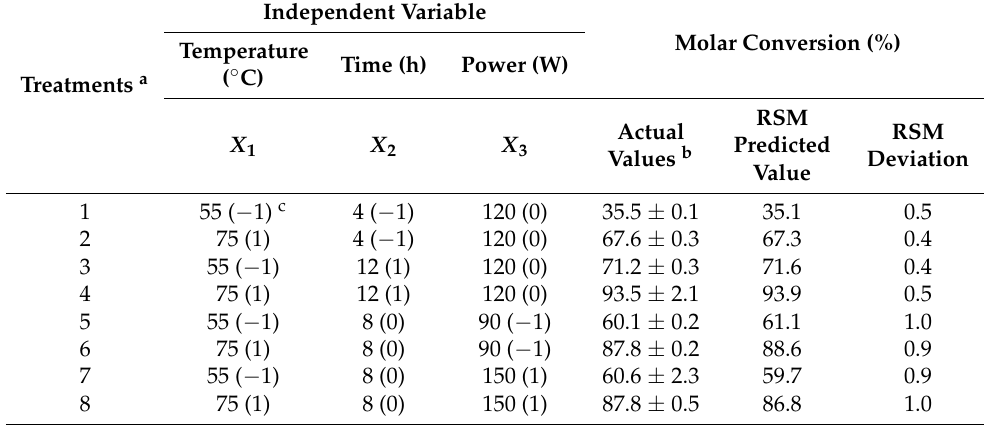
Table 1. Box–Behnken design matrix and responses of dependent variables for the synthesis of octyl cinnamate.